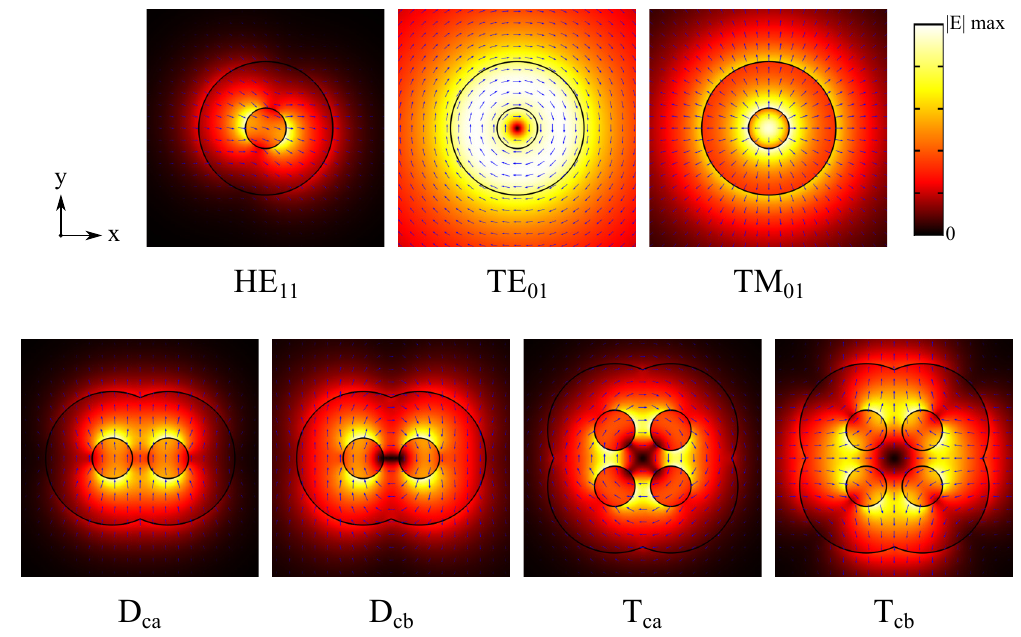
Figure 9. Electric field plots in the xy -cross-section of the coated nanowire oligomer waveguide modes included in the analysis. The color map shows the field norm the transverse field direction. Here, the nanowire diameter is 260 nm, coating thickness is 300 nm, and nanowire separation is 100 nm.